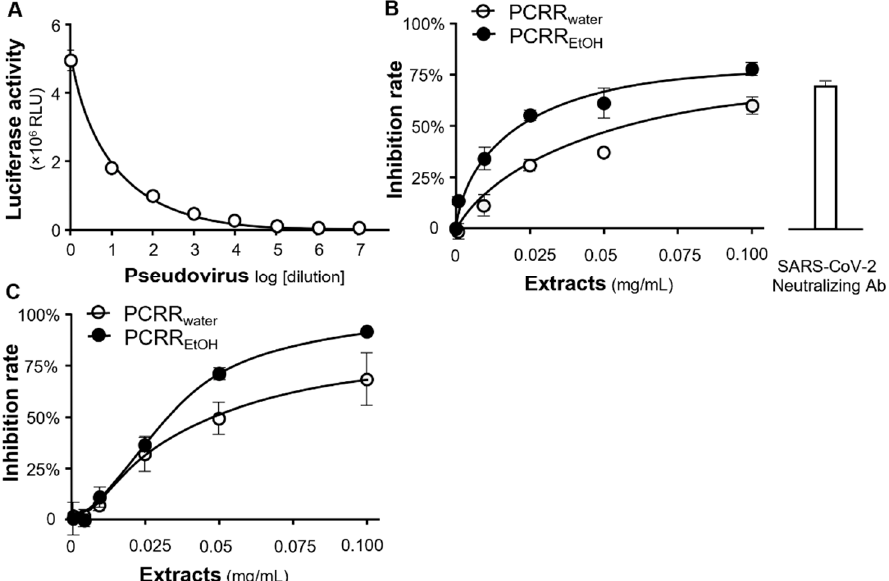
Figure 4. Inhibition of pseudovirus entry. ( A ) The intracellular luciferase activity (implying the rate of pseudovirus entry in RLU) was detected at different concentrations/dilutions of wild-type pseudovirus. ( B ) The entry of wild-type pseudovirus was disrupted by PCRR water and PCRR EtOH in dose-dependent manners. ( C ) These extracts also inhibited the entry of the omicron variant into the host cells. The inhibition rate was calculated based on the luciferase activity, which was normalized to the luciferase activity without any treatment. A SARS-CoV-2 neutralizing antibody at a concentration of 1 µg/mL was employed as a positive control. The data represent mean ± SD; n = 3. In addition to measuring the luciferase activity, we also measured the level of green fluorescence (derived from the ZsGreen plasmid expressed by wild-type